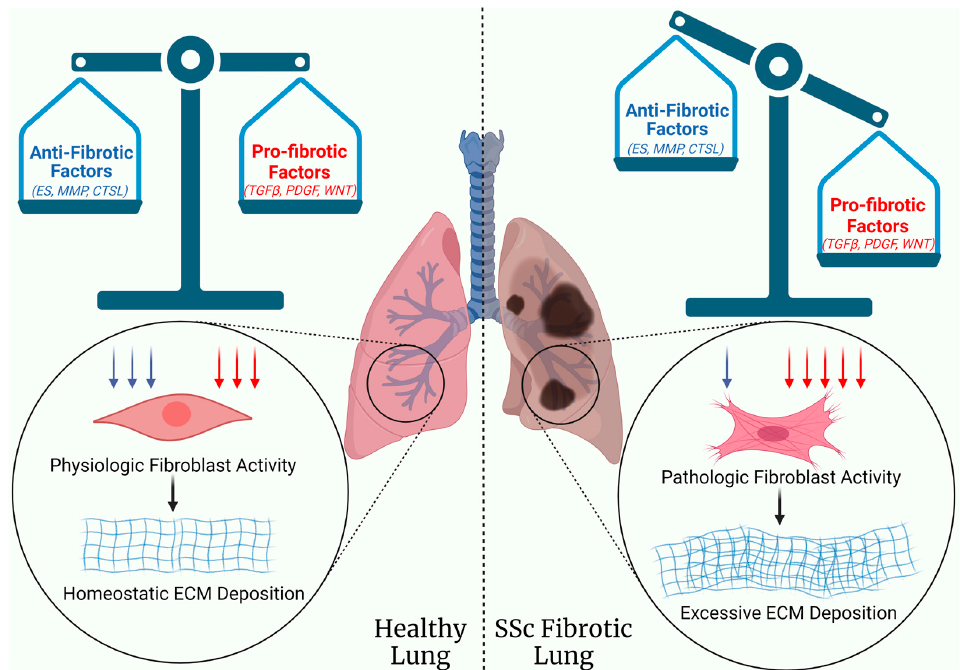
Figure 1. Lung fibrosis in SSc is the result of an imbalance between anti-fibrotic and pro-fibrotic factors, favoring the latter, and resulting in the activation of fibroblasts and the excessive deposition of ECM. ES, endostatin; MMP, matrix metalloproteinase; CTSL, Cathepsin L; TGF β , Transforming Growth Factor Beta; PDGF, Platelet-Derived Growth Factor; WNT, Wingless-Related Integration Site; ECM, extracellular matrix; SSc, systemic